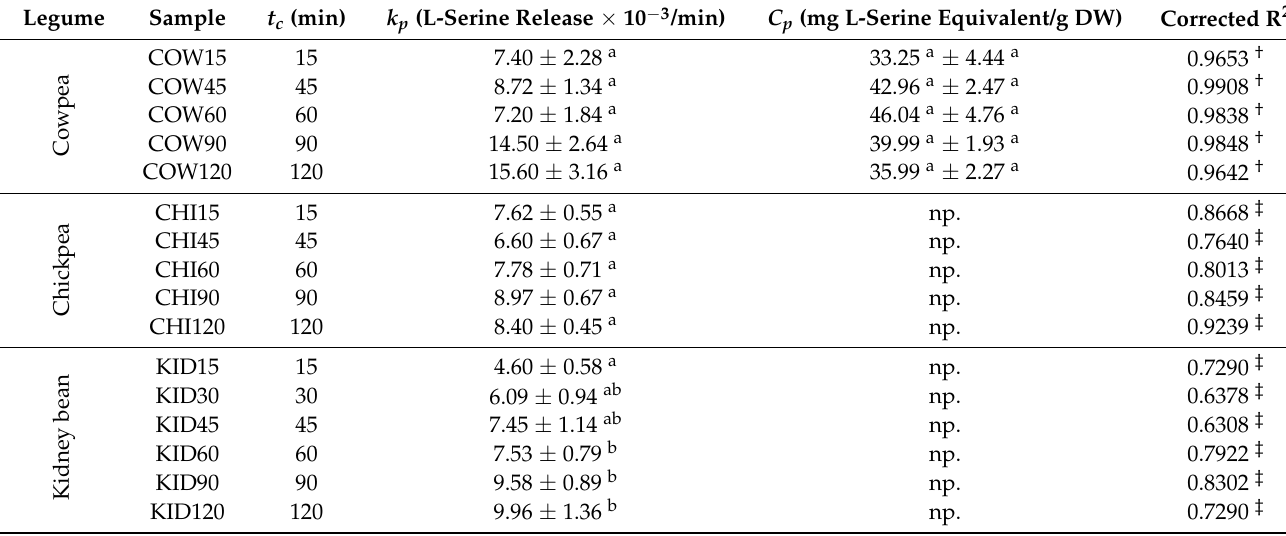
Table 4. Estimated protein digestibility kinetic parameters for different boiled cowpeas, chickpeas and kidney beans during in vitro small intestinal